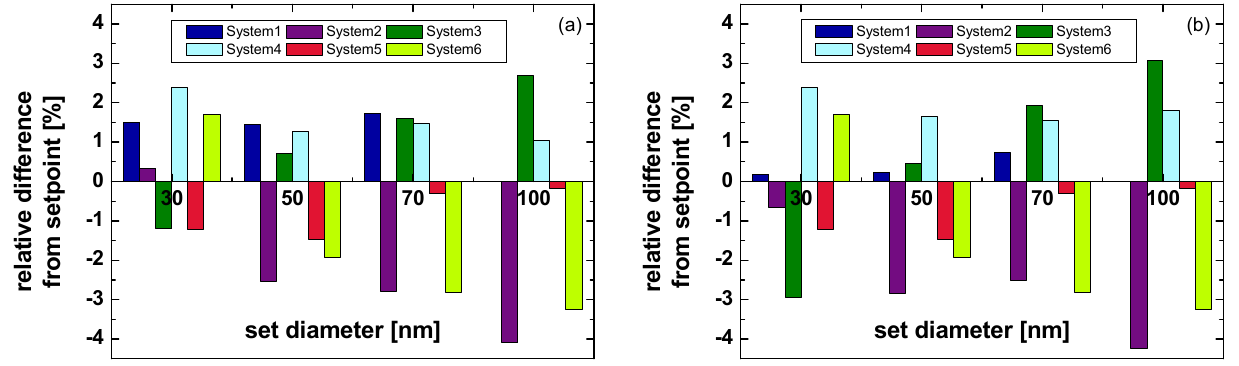
Fig. 2. (a) Externally and (b) internally evaluated growth factor difference for all systems at dry conditions.